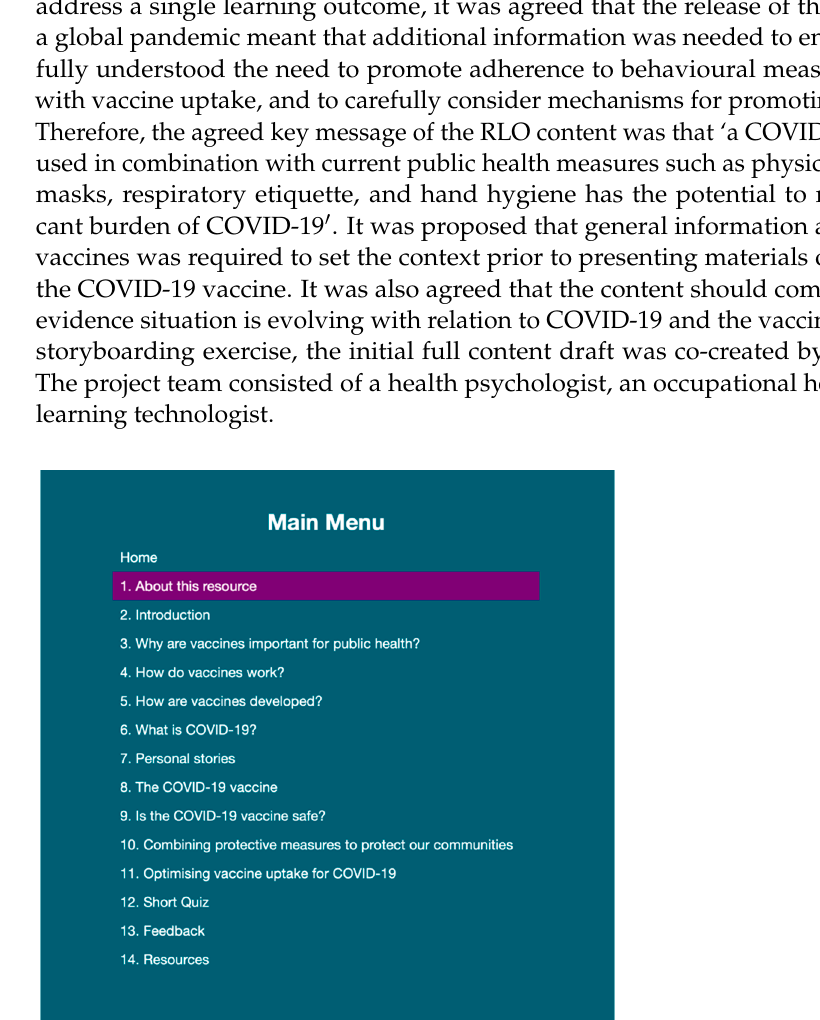
Table 1. Mapping of design principles to RLO design feature Design Principle